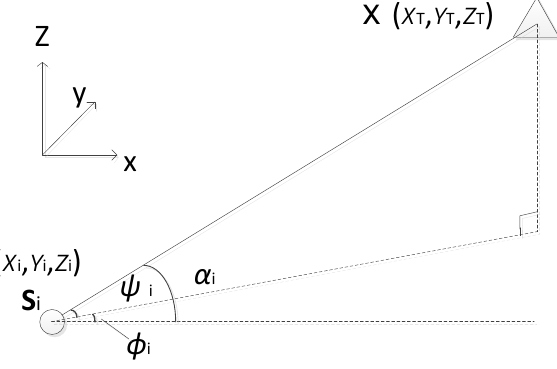
Figure 2. Schematic of orientation cross positioning.